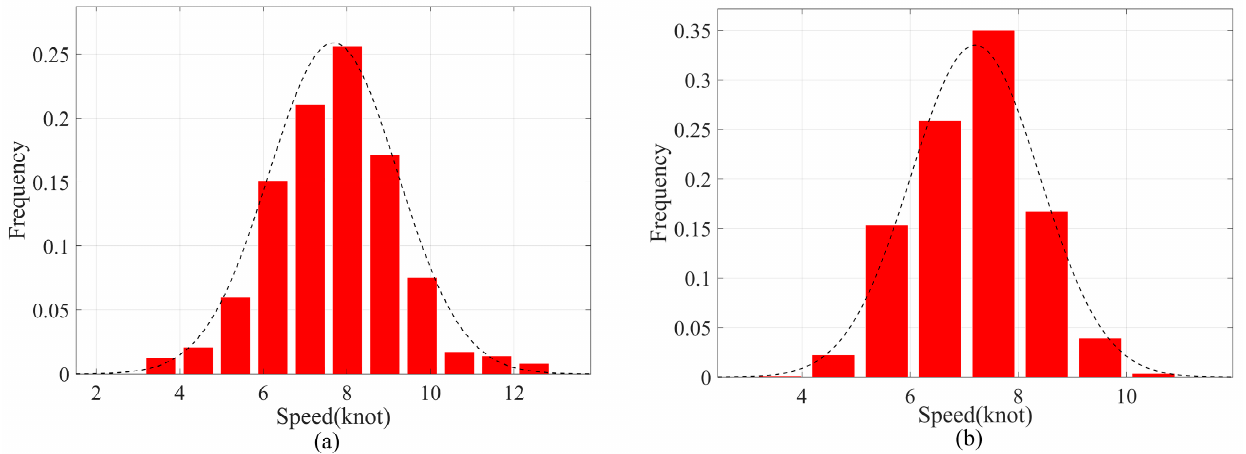
Figure 19. Frequency histogram of incoming route 1 and incoming route 2 in Figure 16. ( a ) Frequency histogram of speed in Figure 16a; ( b ) frequency histogram of speed in Figure 16f.